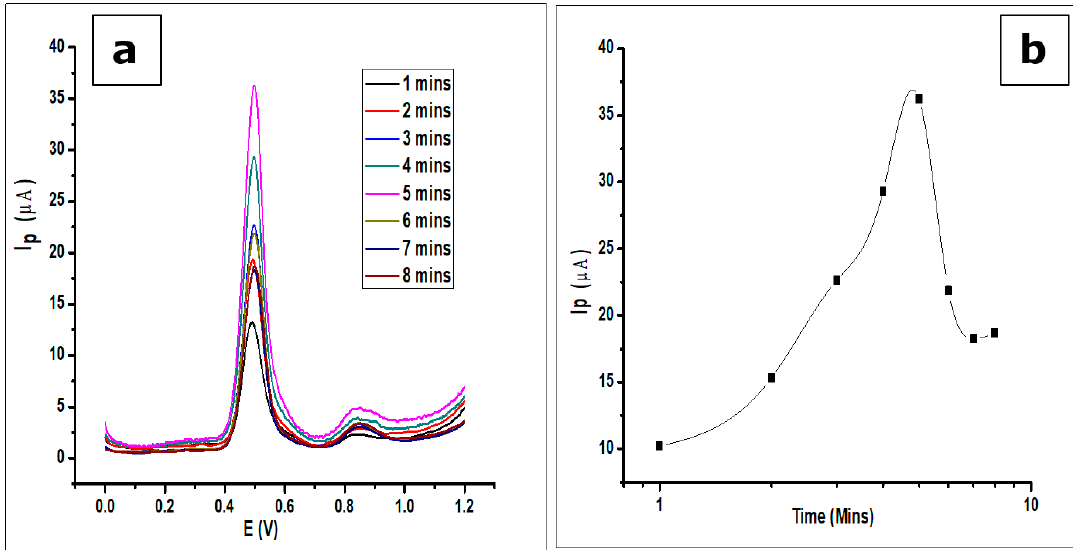
Figure 11. ( a ) DPV voltammograms showing the effect of adsorption time on the determination of 1 × 10 − 3 mol L − 1 GA in a 0.1 mol L − 1 phosphate buffer of pH 2.0 at a scan rate of 100 mVs − 1 ( b ). The plots showing the same effect of adsorption time.